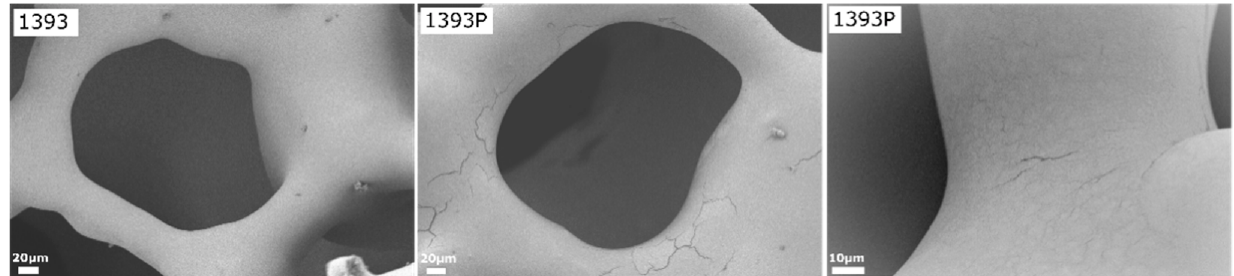
Figure 5. SEM micrographs of uncoated and PGSuc-coated bioactive glass 1393 scaffolds at high magnification (× 500). The right micrograph of 1393P is at higher magnification (× 2000) and shows surface resembling fabric or film, smoothly covering the scaffold’s struts, with a few areas of minor cracking.